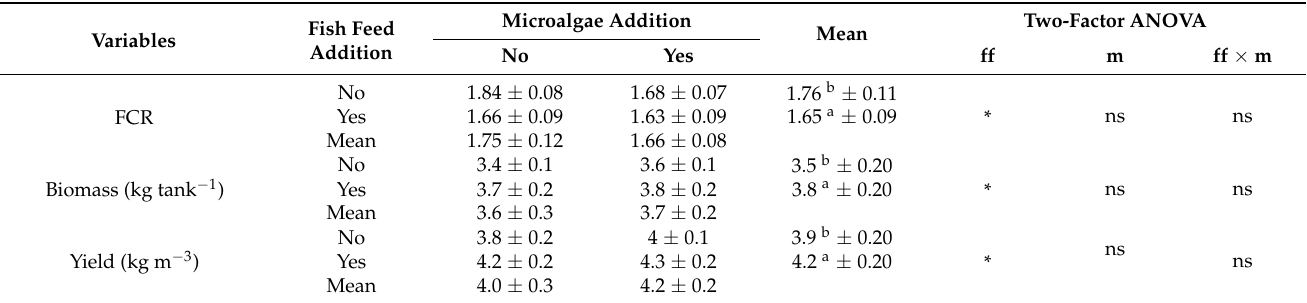
Table 4. Yield performance of the overall integrated system of Pacific white shrimp ( Litopenaeus van- namei ) and Nile tilapia ( Oreochromis niloticus ) reared using biofloc technology for 62 days, evaluating the addition of microalgae and fish feed in a factorial